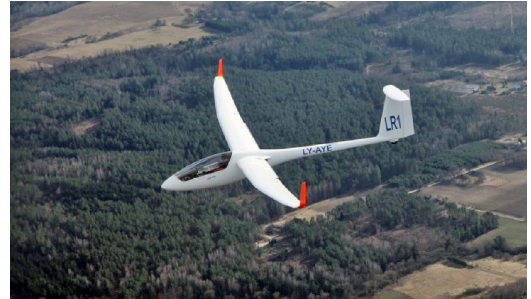
Fig. 11. 3D printed elements inside the miniflaps (Photo: K-E. Seegel)